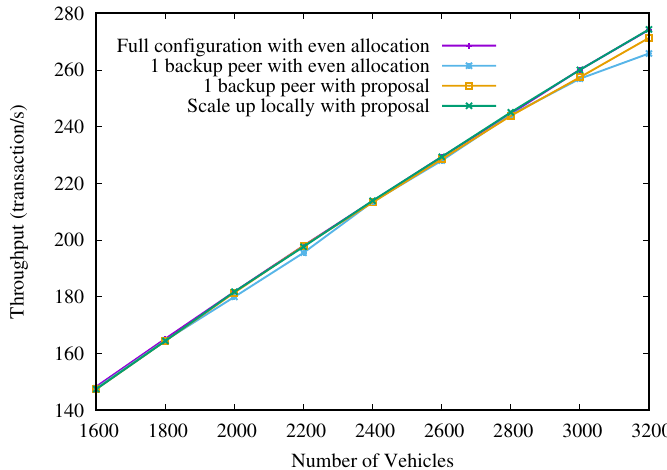
Figure 17. Throughput performance of the system with a backup